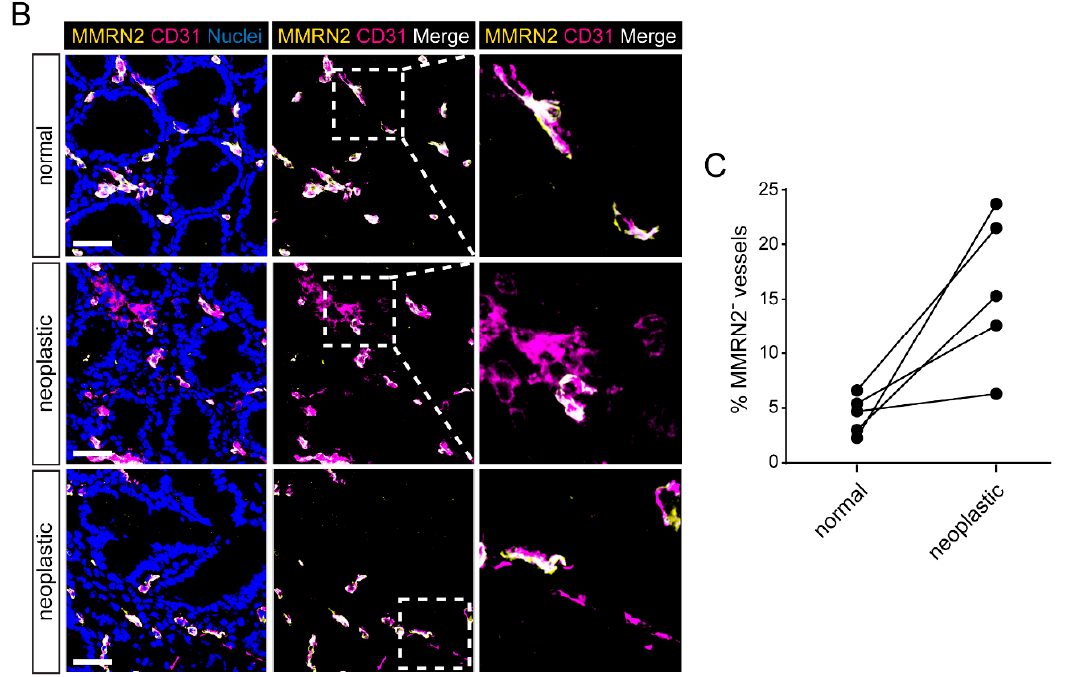
Figure 2. Multimerin-2 expression is lost in a number of gastric cancer-associated vessels. ( A ) Representative images of normal gastric mucosa samples stained with anti-Multimerin-2 (yellow) and anti-CD31 (magenta) antibodies. Nuclei were stained with TO-PRO ® 3 (blue). Scale bar = 30 μ m. ( B ) Representative images showing the colocalization of Multimerin-2 and CD31 in normal gastric mucosa and in gastric cancer samples. Staining were performed as in A. Scale bar = 50 μ m. Magnifications (2.7 ×) are shown in the panels on the right. ( C ) Graph representing the percentage of blood vessels displaying no staining for Multimerin-2 (MMRN2 − ) in normal and neoplastic samples of 5 patients evaluated by IF as in B.